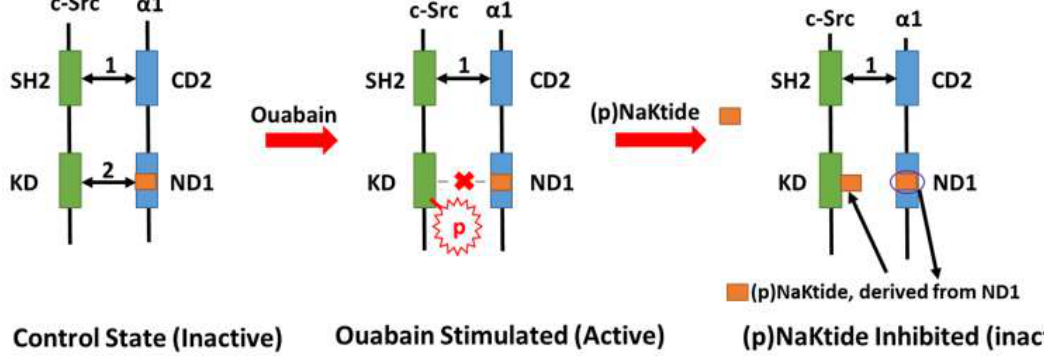
Figure 1. A schematic illustration of action of pNaKtide: Under control state, c-Src SH2 domain binds to α1 CD2 segment (indicated by arrow 1) and c-Src KD binds to α1 ND1 (indicated by arrow 2), which keeps c-Src inactive. Upon ouabain binding to the α1 subunit, the α1 subunit favors E-2P conformational status and c-Src KD released from α1 subunit that leads to phosphorylation of Tyr418 in c-Src KD. NaKtide and pNaKtide are derived from 20 aa (Ser415-Gln434) in α1 ND1, which can bind to the c-Src KD for the competitive binding of α1 ND1 and KD, thus preventing phosphorylation of Tyr418 in c-Src KD. In the illustration, ouabain is used as a representative of cardiotonic steroids. SH2, c-Src SH2 domain; KD, c-Src kinase domain; CD2, α1 subunit CD2 segment; ND1, α1 subunit ND1 segment.